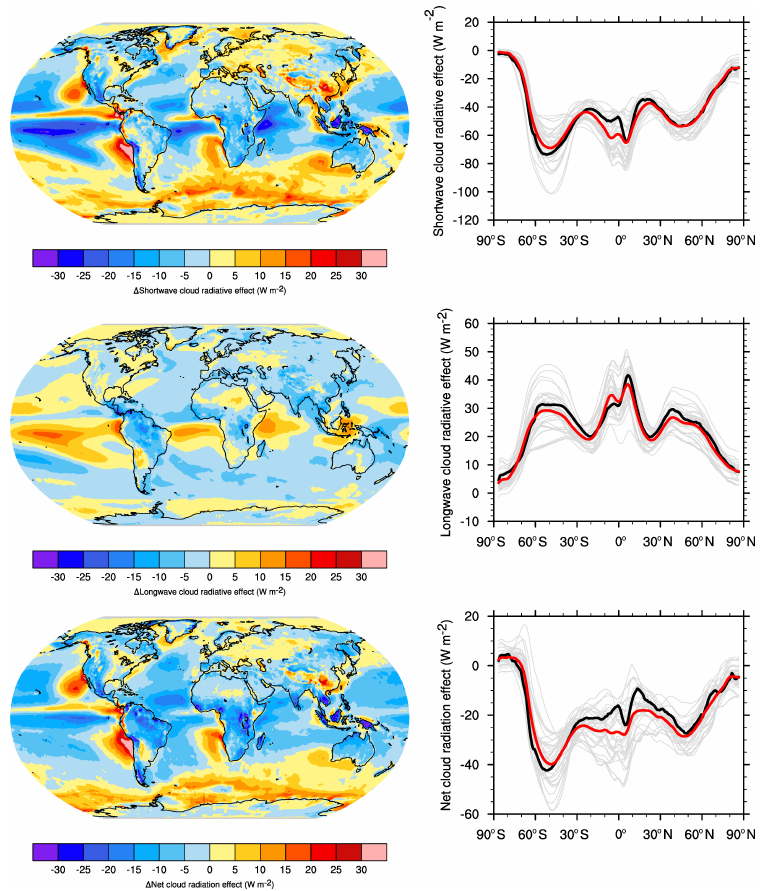
Figure 12. Climatological (1985–2005) annual-mean cloud radiative effects from the CMIP5 models against CERES EBAF (2001–2012) in Wm − 2 . Top row shows the shortwave effect; middle row the longwave effect, and bottom row the net effect. Multi-model-mean biases against CERES EBAF 2.7 are shown on the left, whereas the right panels show zonal averages from CERES EBAF 2.7 (black), the individual CMIP5 models (thin grey lines), and the multi-model mean (red). The multi-model mean longwave CRE is overestimated in models, particularly in the Pacific and Atlantic south of the inter-tropical convergence zone (ITCZ) and in the South Pacific convergence zone (SPCZ). The longwave CRE is underestimated over Central and South America as well as parts of Central Africa and southern Asia. The most striking biases in the multi-model mean shortwave CRE are found in the stratocumulus regions off the west coasts of North and South America, southern Africa, and Australia. Despite biases in component cloud properties, simulated CRE is in quite good agreement with observations. Reproducing Fig. 9.5 of Flato et al. (2013) and produced with namelist_flato13ipcc.xml